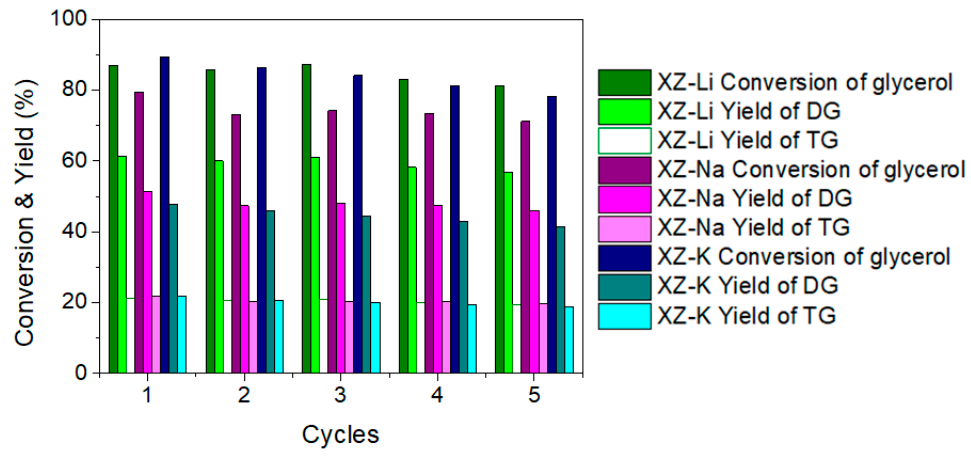
Figure 7. Recycling of XZ-M for the etherification reaction of glycerol.